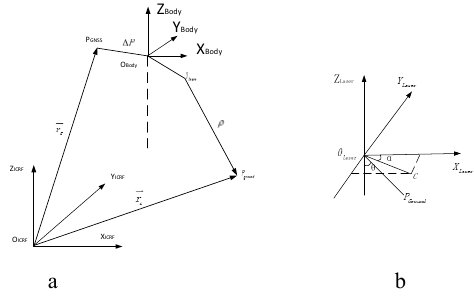
Figure 1. Principle of star-borne laser altimetry